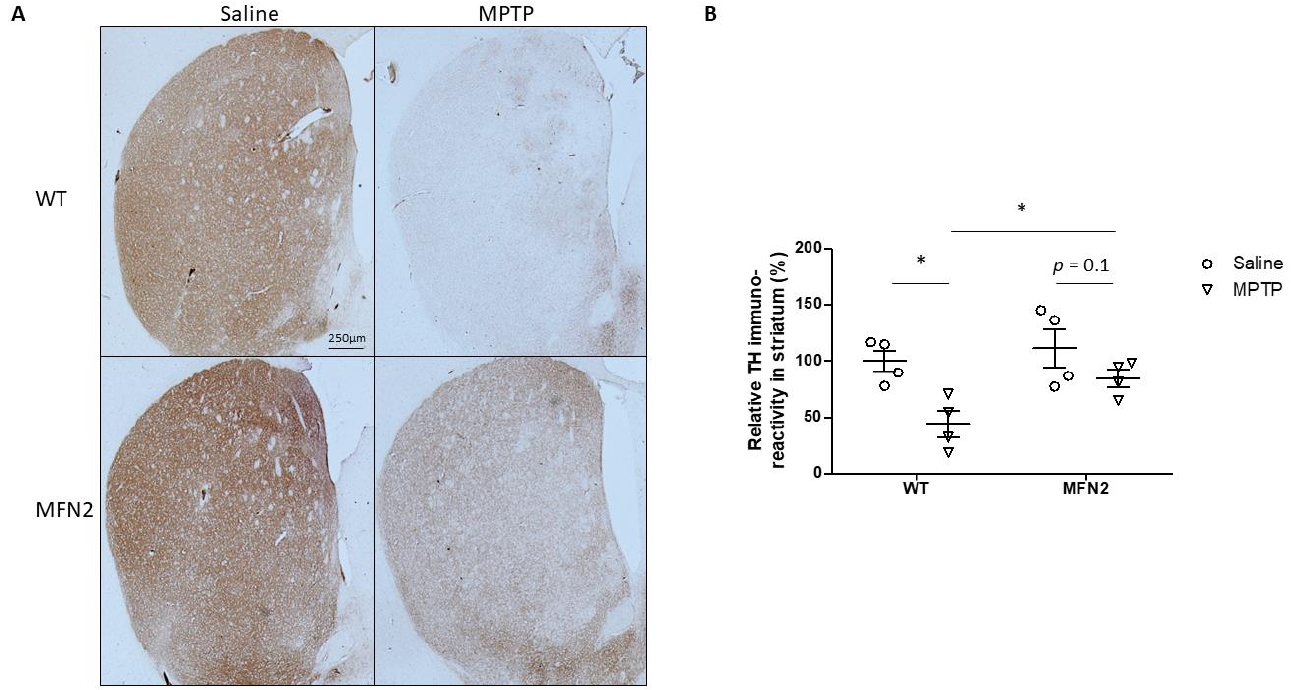
Figure 5. MFN2 overexpression rescued MPTP-induced loss of TH+-terminals in the striatum. Representative pictures of TH+ terminal fibers of dopaminergic neurons in the striatum ( A ) and quantification of the relative fiber density in the striatum ( B ) are shown. ( n = 4; * p < 0.05 compared to the control) .